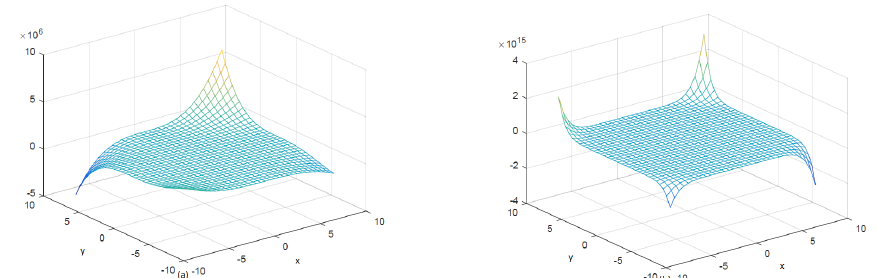
Figure 11: Plotting of (a) M-polynomial and (b) NM-polynomial of